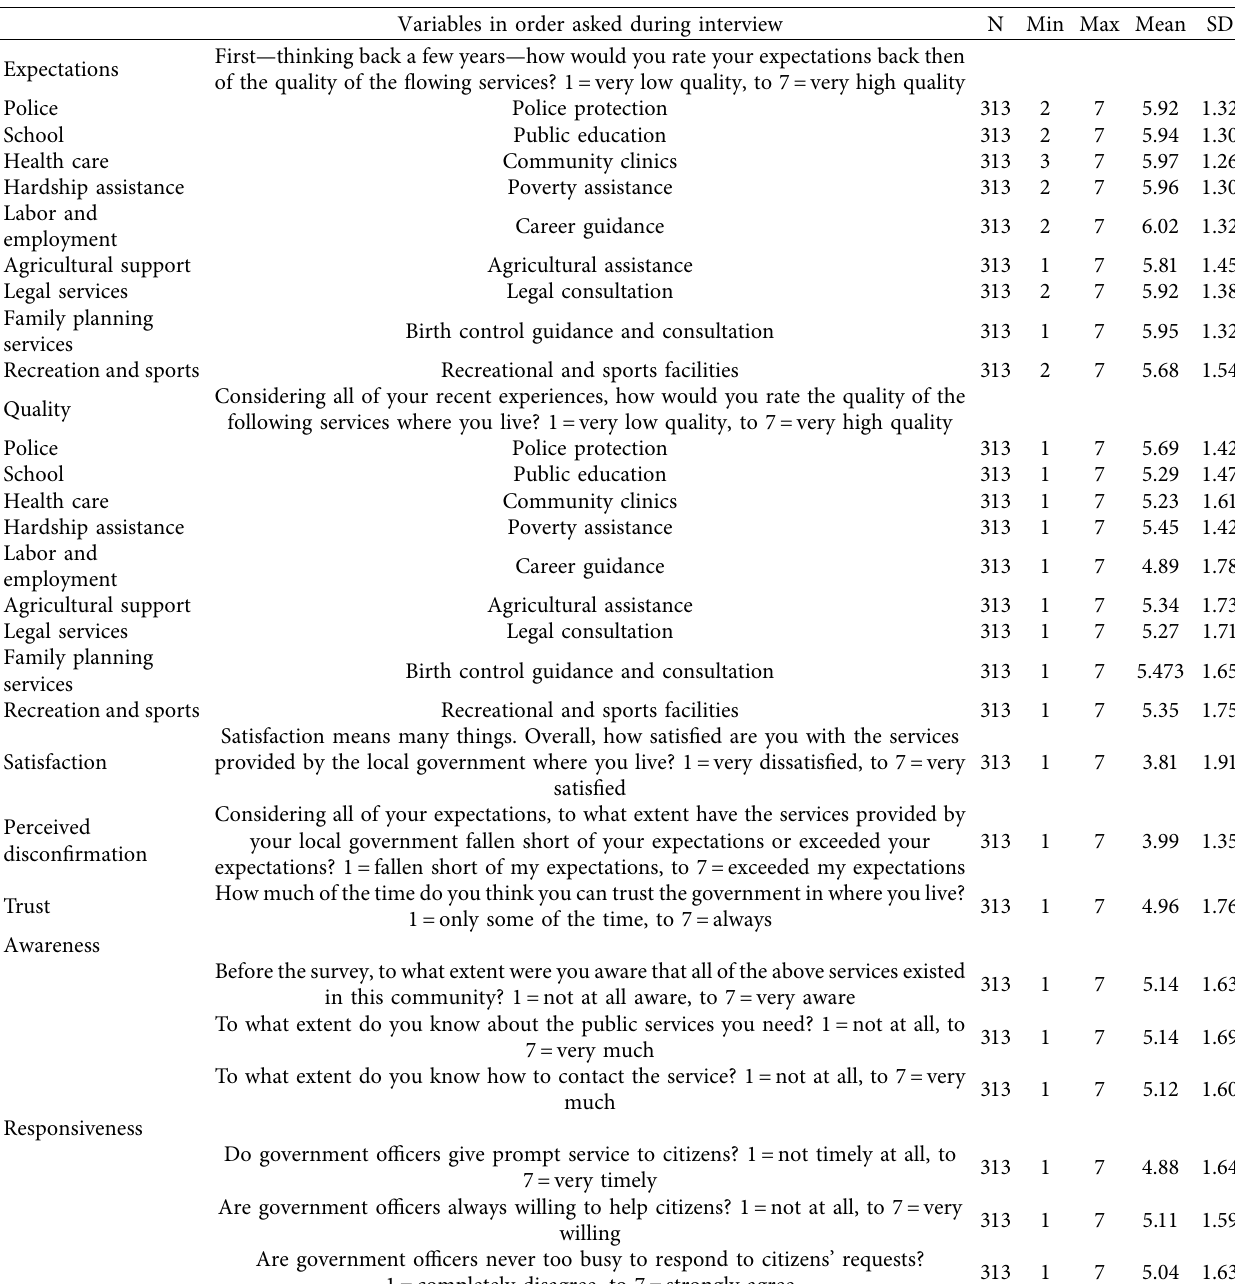
Table 1: Question wording and descriptive statistics for the model